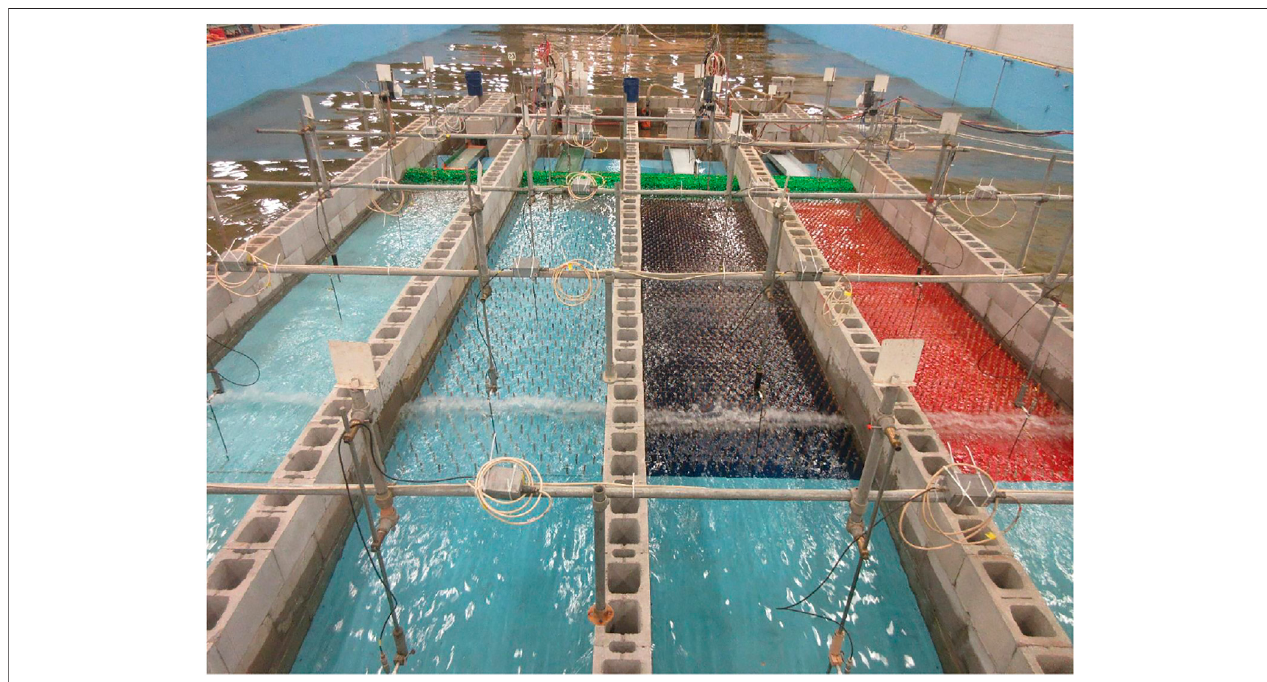
FIGURE 1 | Simultaneous parallel testing of wave attenuation across four coastal marshes with different densities of surrogate vegetation (onshore view).